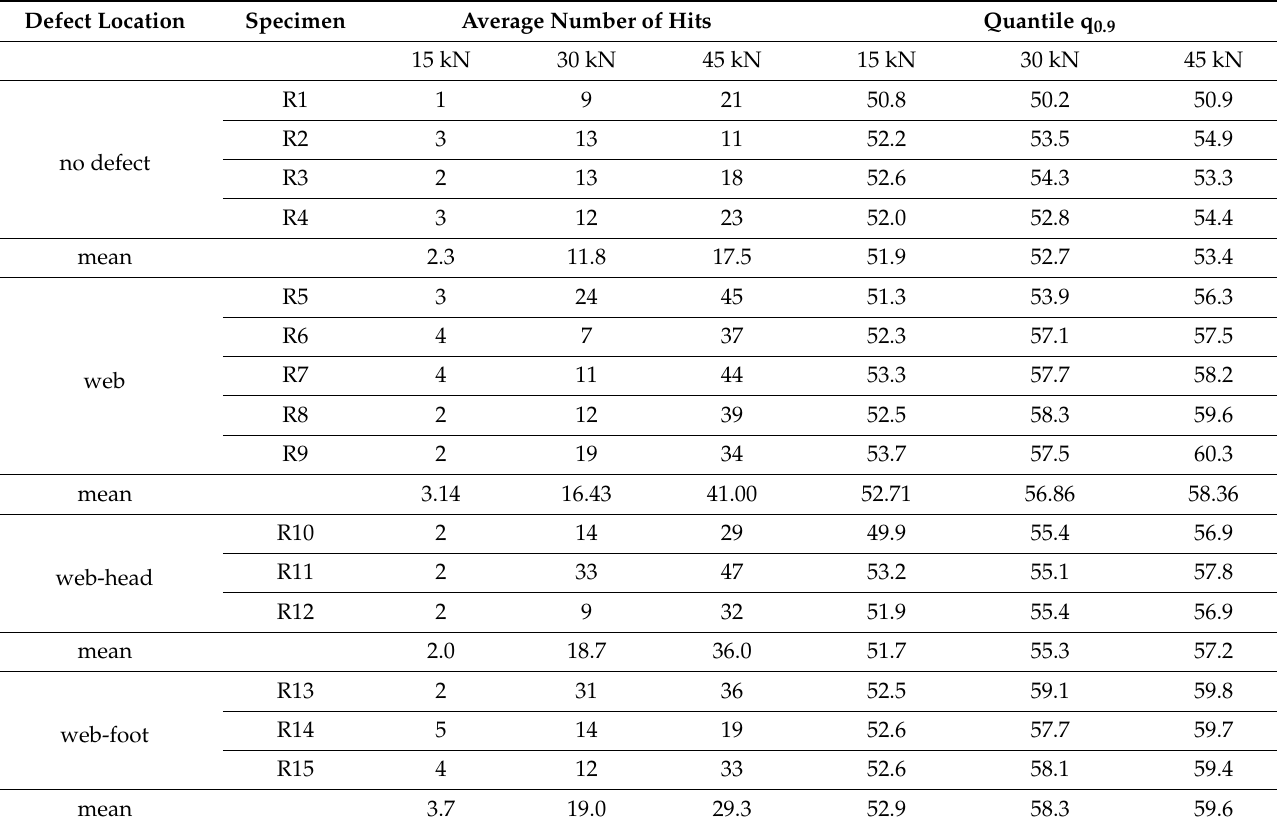
Table 3. Values of AE parameters obtained during